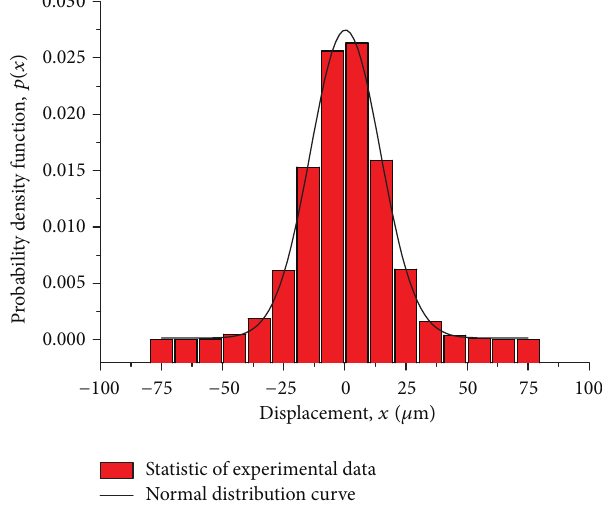
Figure 14: Displacement power spectral density of the fuel rod in two cases at 𝑞 V = 0.62 m 3 / h.